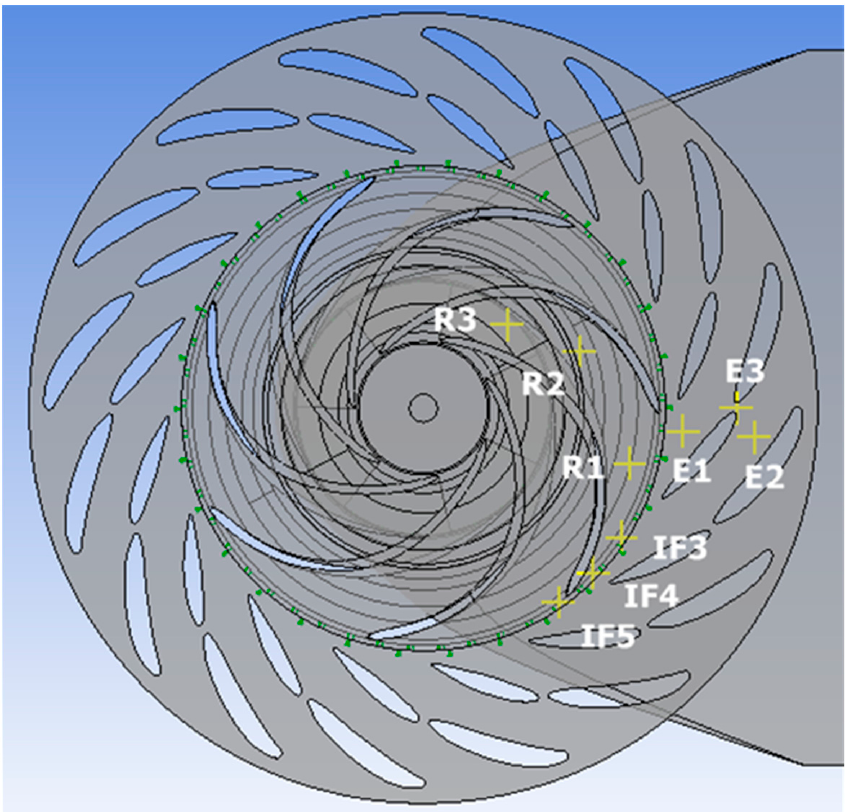
Figure 4. Location of the pressure monitoring points used.